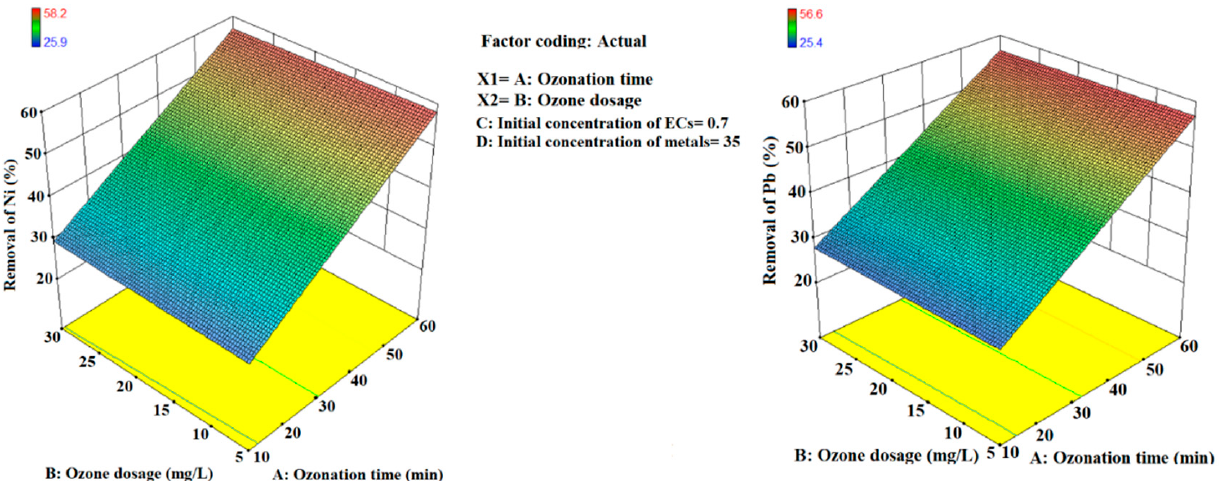
Figure 3. 3D surface plots for removal of TND and DMP.